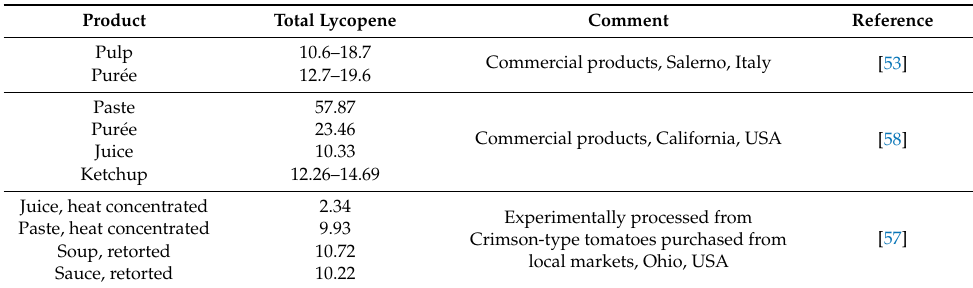
Table 4. Lycopene content in tomato products (converted to mg / 100 g FW). Literature review. Values in italics are obtained by spectrophotometry, otherwise